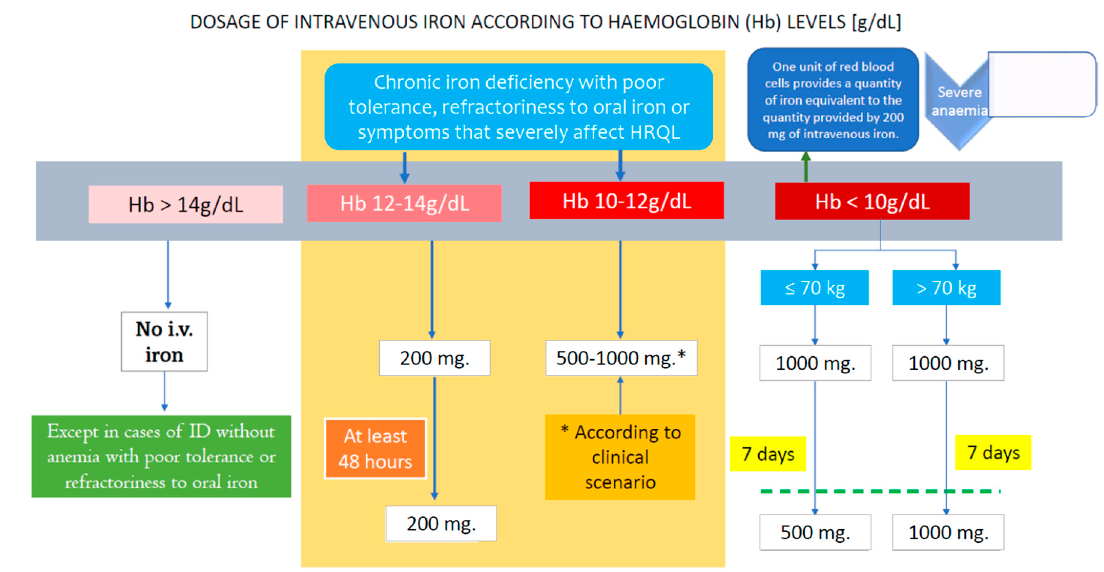
Figure 6. Dosage of intravenous iron according to hemoglobin (Hb) levels (g/dL) (adults). * Dosage may vary depending on the patient’s clinical condition and the physician’s clinical judgment. Hb: haemoglobin; h: hours; kg: kilograms of patient